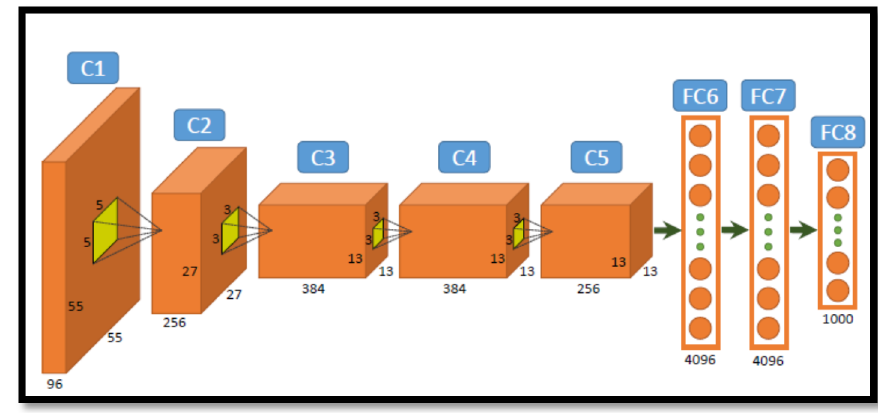
Figure 3. The overall architecture of AlexNet [23].